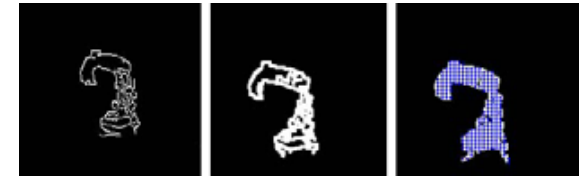
Fig. 5. Robot edges and features